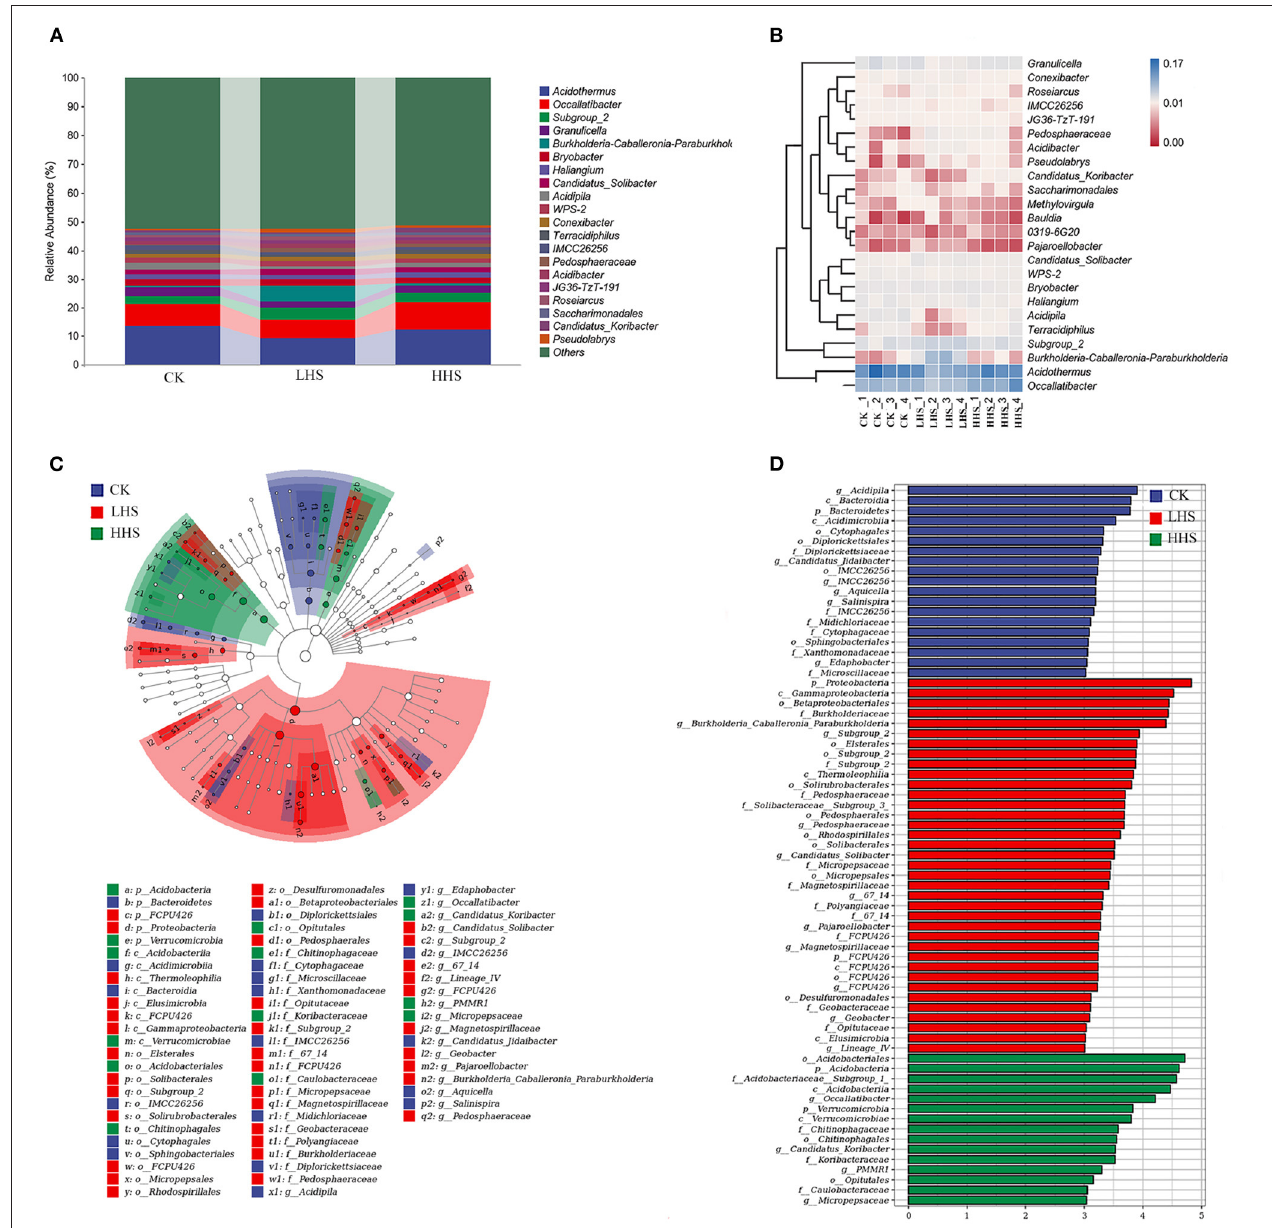
FIGURE 4 | Comparison of bacterial communities in CK, LHS and HHS samples. (A) Bacterial taxa at genus level. (B) Heatmap showing changes in microbial community on genus level. (C) Cladograms indicate the phylogenetic distribution of microbial lineages associated with the three treatments. Each circle diameter is proportional to the taxon abundance. The strategy of multiclass analysis is strict (all classes differential). Circles represent phylogenetic levels from Kingdom to genus. (D) LDA bars indicate microbial groups within three treatments with LDA score higher than 3.0. The difference in abundant clades of each treatment are represented by colors as in cladograms, and the LDA scores of these clades indicate the degree of statistically and biologically difference. CK, control (25/20 ◦ C); LHS, light heat stress (35/30 ◦ C); HHS, high heat stress (40/35 ◦ C); p, phylum; o, order; c, class; f, family; g,